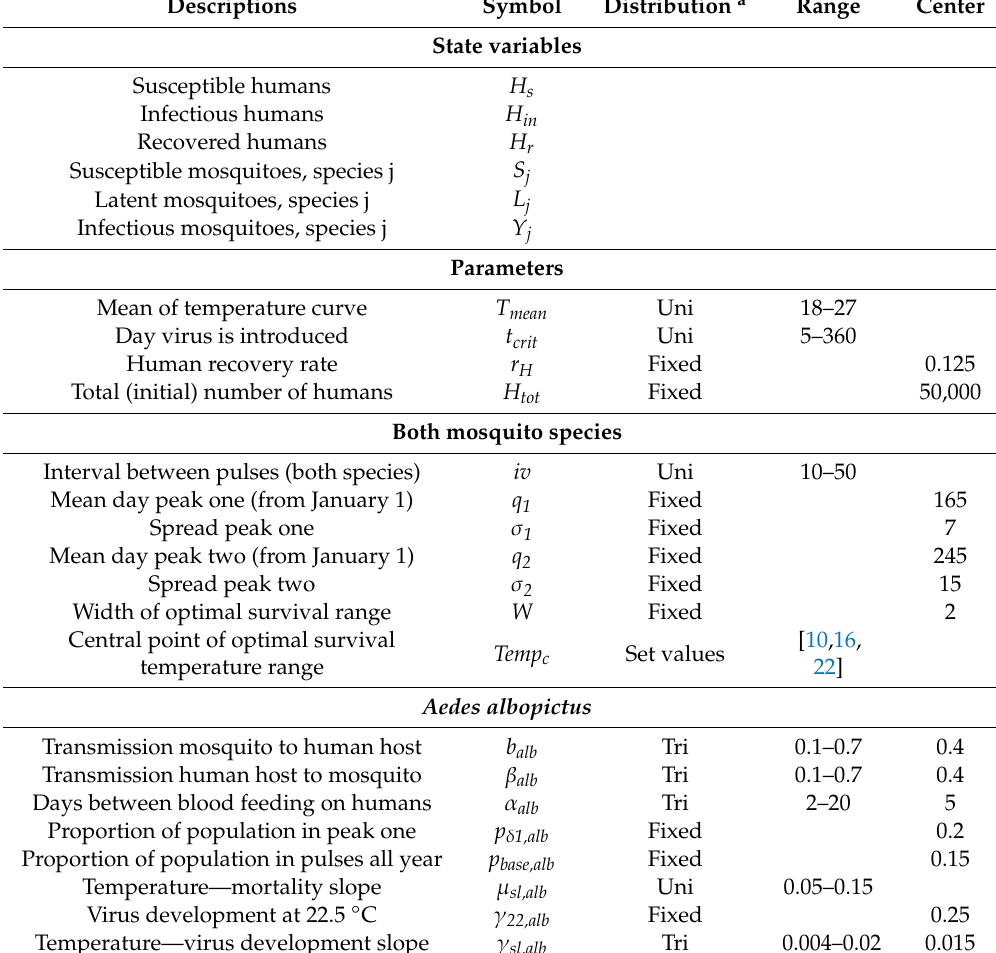
Figure 1. Flow chart of model. Temperature dependent functions shown in green text, seasonal mosquito recruitment in red, and strain-specific transmission parameters (infection) in light blue (humans) and dark blue (mosquitoes). Species A is Aedes aegpti and Species B is Aedes albopictus. Table 1. State variables, parameters, and parameter distributions used in the model and LHC analysis.